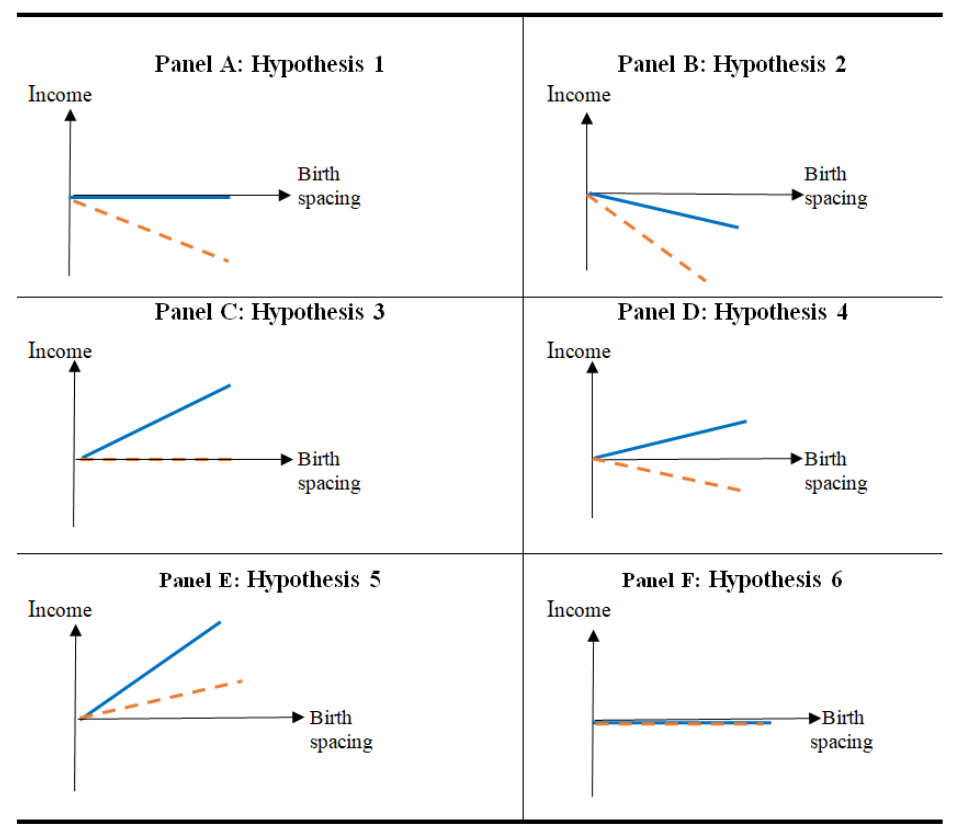
Figure 1 : Potential positive and/or negative impact from birth